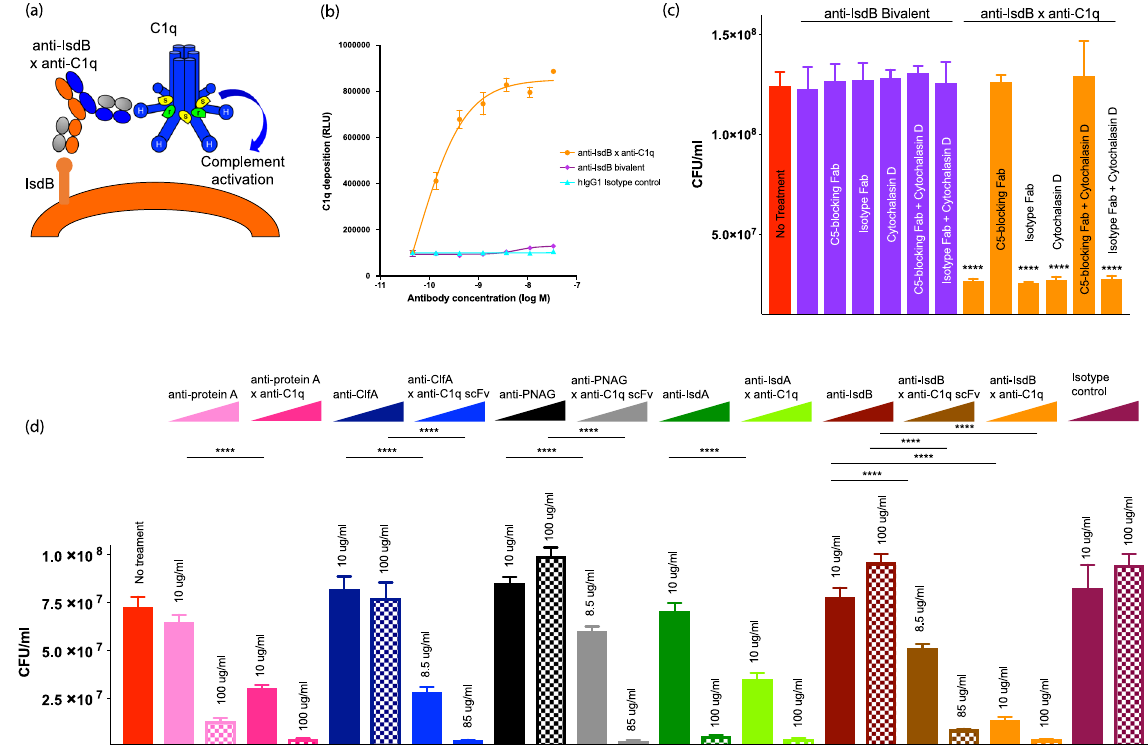
Figure 2. Bispecific antibodies targeting IsdB and C1q can increase complement deposition on the surface of S . aureus leading to cell death. ( a ) Proposed mechanism of action of the anti-IsdB x anti-C1q antibody. One arm of the antibody (orange and gray) targets the S . aureus surface antigen IsdB with high affinity. The other arm (blue and gray) targets the complement C1q protein. Engagement of multiple C1q heads by multiple bsAbs can lead to activation of complement. ( b ) C1q deposition on S . aureus was measured using a plate-based format. S . aureus Newman was coated onto plates and then incubated with NHS in the presence of anti-IsdB x anti- C1q bsAb, an anti-IsdB bivalent antibody or an isotype control antibody. C1q deposition was measured with a primary antibody specific for C1q and an HRP-conjugated secondary antibody. Results are plotted as mean ± standard deviation. ( c ) Whole blood assays were performed by incubating S . aureus Newman with blood alone (far left red column), blood with an anti-IsdB bivalent antibody (columns 2–7; purple) or blood with anti- IsdB x anti-C1q bsAb (columns 8–13; orange). The antibodies were combined with either a C5 blocking Fab (columns 3 and 9), an isotype control Fab (columns 4 and 10), or cytochalasin D (columns 5 and 11), both the C5-blocking antibody and cytochalasin D (columns 6 and 12) or both the isotype control Fab and cytochalasin D (columns 7 and 13). Bacterial growth was enumerated by plating. **** P < 0.0001, one-way ANOVA with Dunnett’s test showing samples significantly different from no treatment sample. Results are plotted as mean with standard deviation. ( d ) bsAbs recognizing C1q and different antigens on the surface of S . aureus were produced. Blood assays were performed as described above with two concentrations of antibody. Full length- antibodies were tested at 10 and 100 μ g/ml, antibodies with an scFv arm were tested at 8.5 and 85 ug/ml (the molar equivalent of the full-length antibodies). Results are plotted as mean with standard deviation. * P < 0.05, ** P < 0.01, *** P < 0.001, **** P < 0.0001, one-way ANOVA showing bsAb samples significantly different from the corresponding bivalent